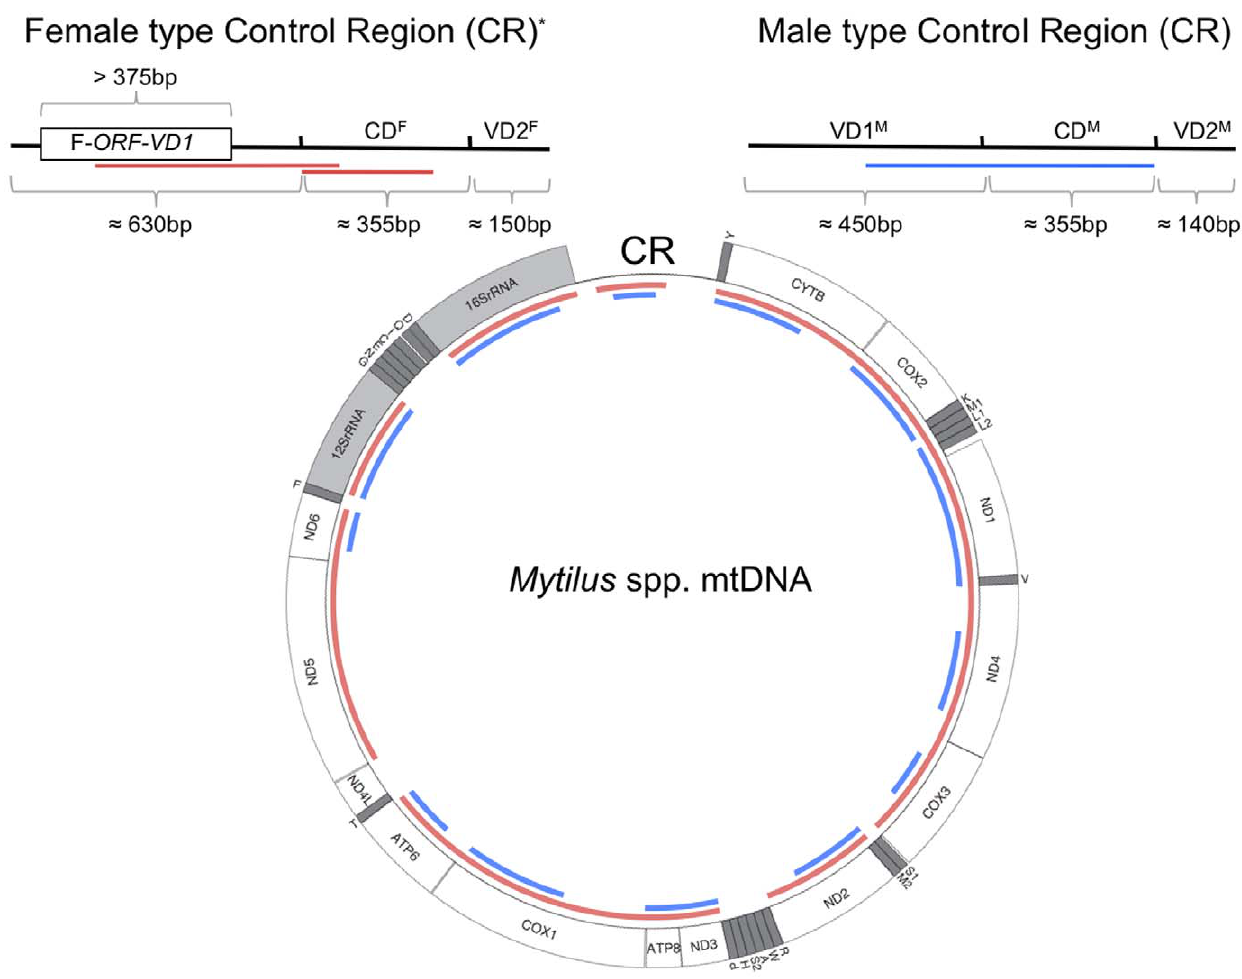
Figure 1. A typical Mytilus mitochondrial genome. All genes are encoded on the same strand. Gene identities: nd1-6 and nd4l , NADH dehydrogenase subunits 1–6 and 4L; cytb , cytochrome b; cox1-3 , cytochrome c oxidase subunits I–III; atp6-8 , ATP synthase subunit 6 and 8 (protein- coding genes in white); 12SrRNA and 16SrRNA, small and large subunits of ribosomal RNA (in light gray). Transfer RNA genes are depicted by one- letter amino acid codes (in gray). The red and blue lines at the inner periphery of the ring represent EST sequences for the F and M mt genomes of M. edulis/M. galloprovincialis , respectively. Schematics of the structure of a typical F-type (left) and M-type (right) control regions, which are located between the 16SrRNA and trnY genes, are shown. The F- ORF-VD1 is identified in the F-type control region. CR, control region; CD, conserved domain; VD1, variable domain 1; VD2, variable domain 2 [39,40]. The mean size of each domain of the CR is shown. *The ‘‘standard’’ F-type CR of M. trossulus , which is a F/M recombinant CR, is not